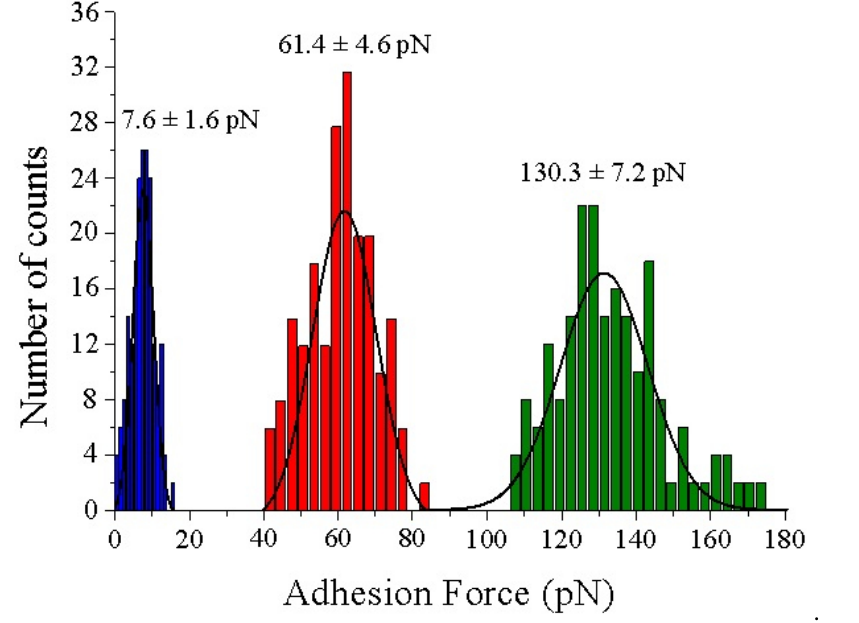
Figure 6. Force histograms analysis and Gaussian fitting for the specific adhesion forces found for the complexes formed between the thiol layer (blue), avidin (red) and streptavidin (green) with biotinylated tips, respectively. N 200 for each condition.